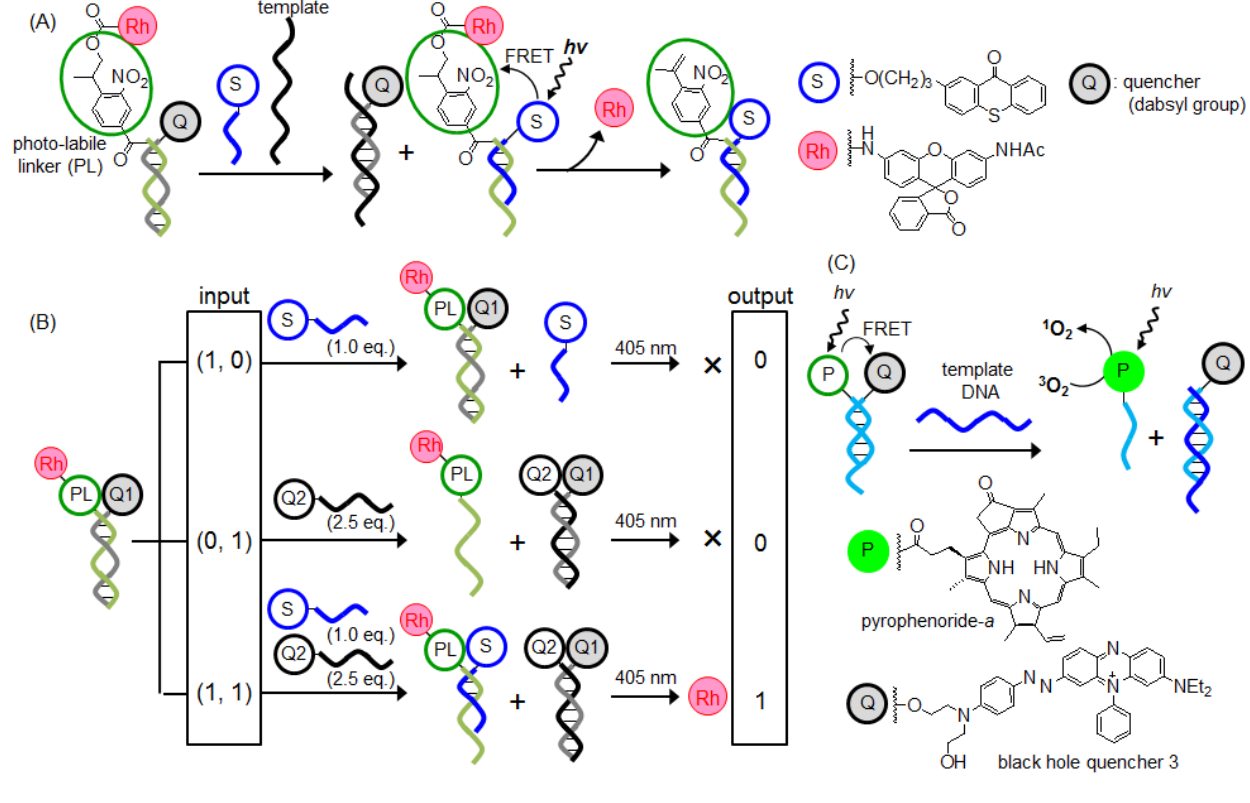
Figure 2. Schematic representation of ( A ) the photorelease system based on the energy transfer from the sensitizer to the linker; ( B ) the logic gate (AND gate); and ( C ) the 1 O generation system based on a templated photoactive